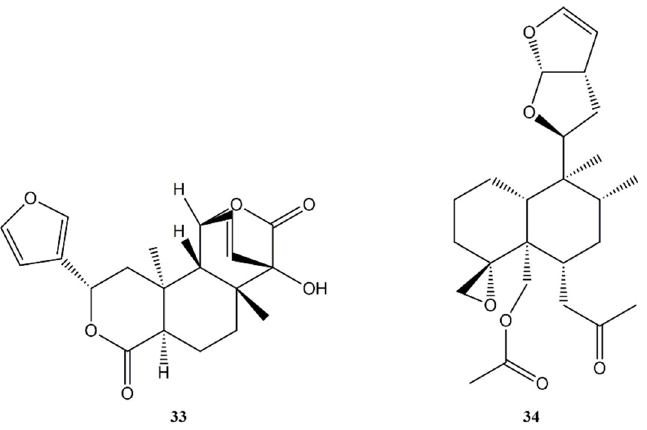
Figure 6. Structures of bioactive trans and cis clerodane diterpenes: Columbin ( 33 ); Clerodin ( 34